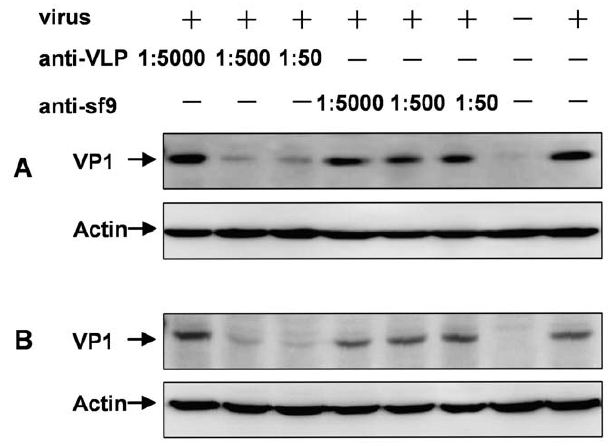
Figure 8. Inhibitory effect of the antisera on EV71 attachment to cells. Antisera at different dilutions (1:50, 1:500, and 1:5,000) were mixed with 400 m l of EV71 containing 9 6 10 6 TCID 50 , and incubated for 1 hour at 37 u C. The mixtures were added to (A) RD or (B) Vero cells for incubation for 1 hour at 4 u C to allow virus attachment to the cells. After incubation, the cells were washed with cold PBS three times, collected, and subjected to Western blotting with a polyclonal antibody against EV71 VP1. For loading control, an antibody against actin was also used in Western blotting.